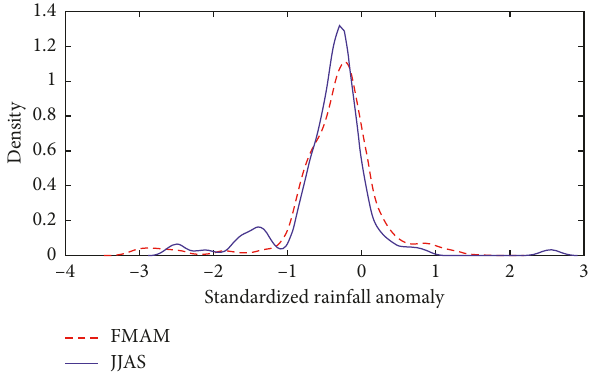
Figure 3: Probability density function (PDF) plot of the FMAM and JJAS standardized rainfall